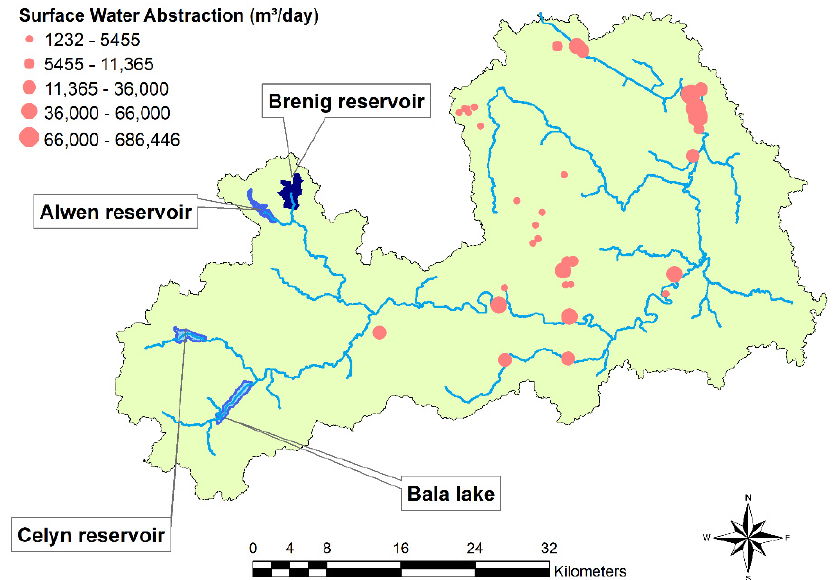
Figure 8. Significant surface water abstraction in the Dee River basin.